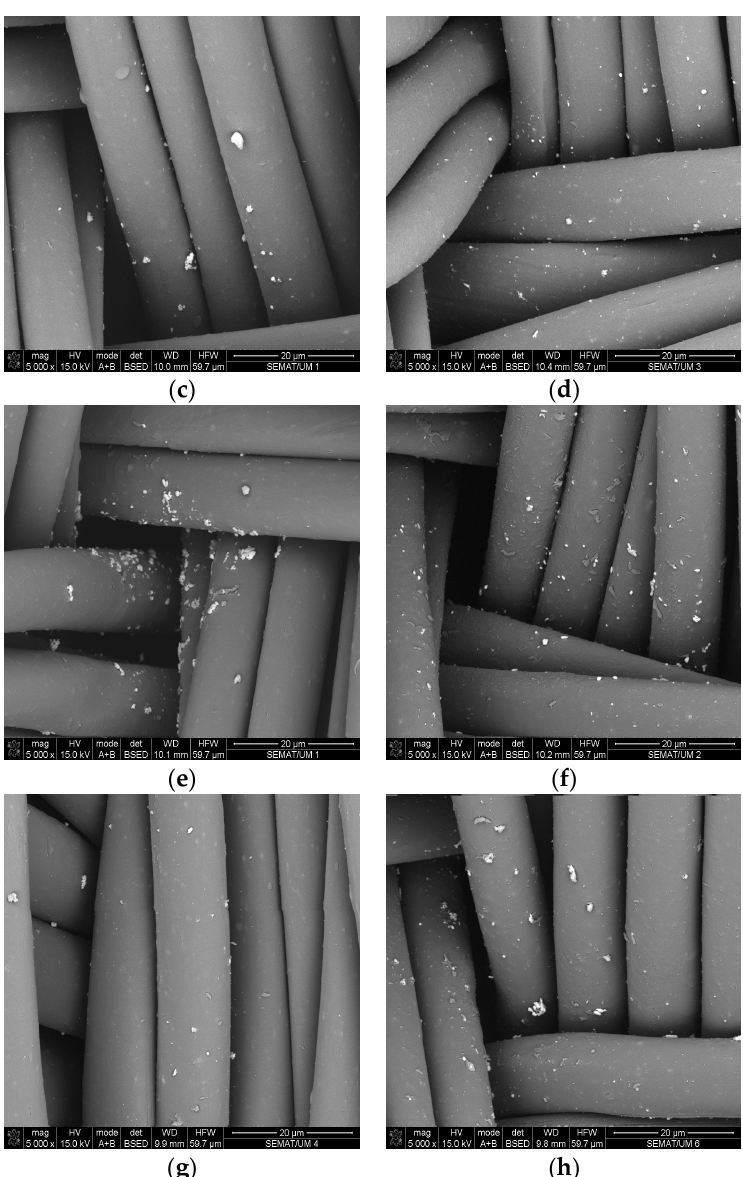
Figure 3 . SEM images of untreated ( a , c , e and g ) and DBD plasma-treated ( b , d , f and h ) PA66 samples Figure 3. SEM images of untreated ( a , c , e , g ) and DBD plasma-treated ( b , d , f , h ) PA66 samples with with AgNPs deposited by spray ( a and b ), exhaustion at 30 °C ( c and d ), exhaustion at 70 °C ( e and f ) AgNPs deposited by spray ( a , b ), exhaustion at 30 ◦ C ( c , d ), exhaustion at 70 ◦ C ( e , f ) and exhaustion at and exhaustion at 100 °C ( g and h ), with a magnification of 5000×. 100 ◦ C ( g , h ), with a magnification of 5000 ×